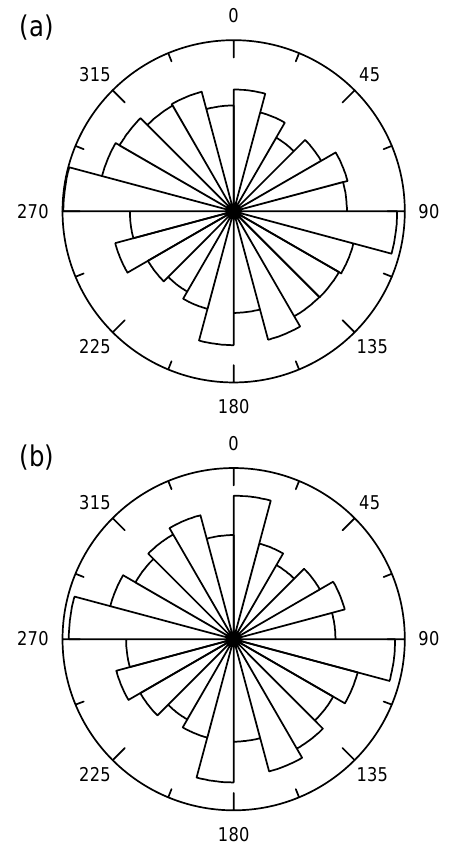
Fig. 8. Distribution (relative frequency) of the directions of ∂ B /∂t in horizontal plane. (a) year 2003, (b) period between 24 October and 1 November